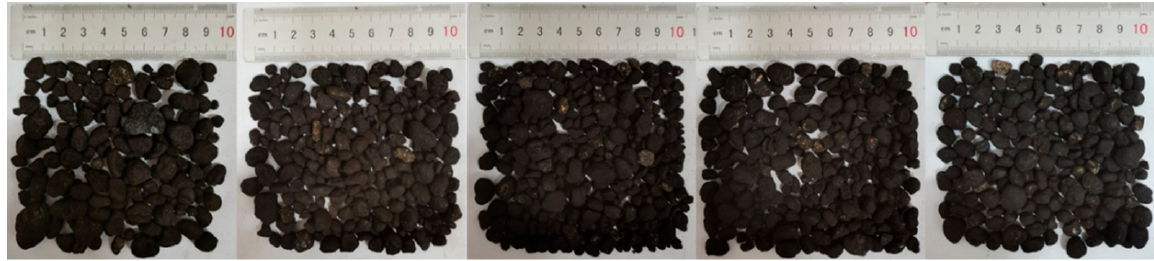
Figure 10. PSD of polymetallic nodules after passing different pump times (the leftmost is the first time, and the rightmost is the fifth time).